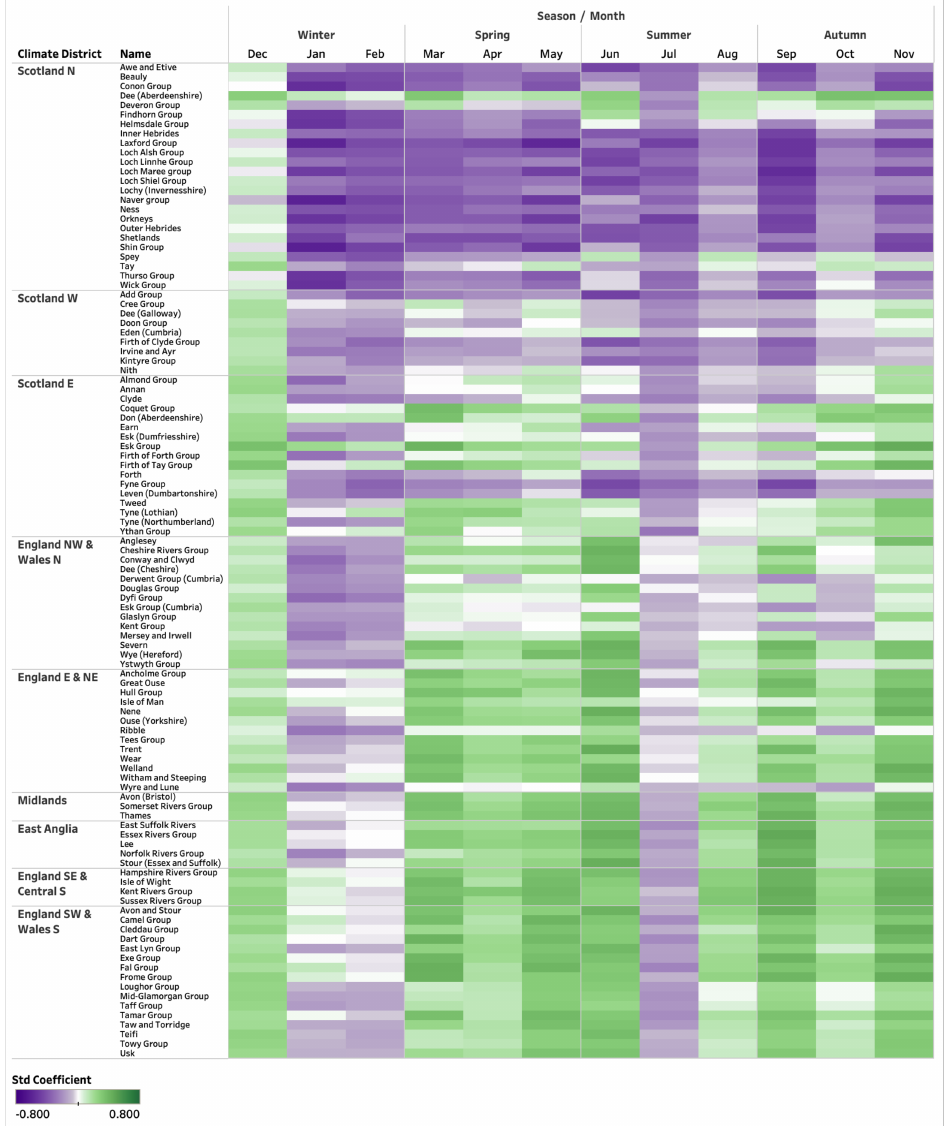
Figure 7. Standardised coefficient values for the SCA index from the multivariate regression